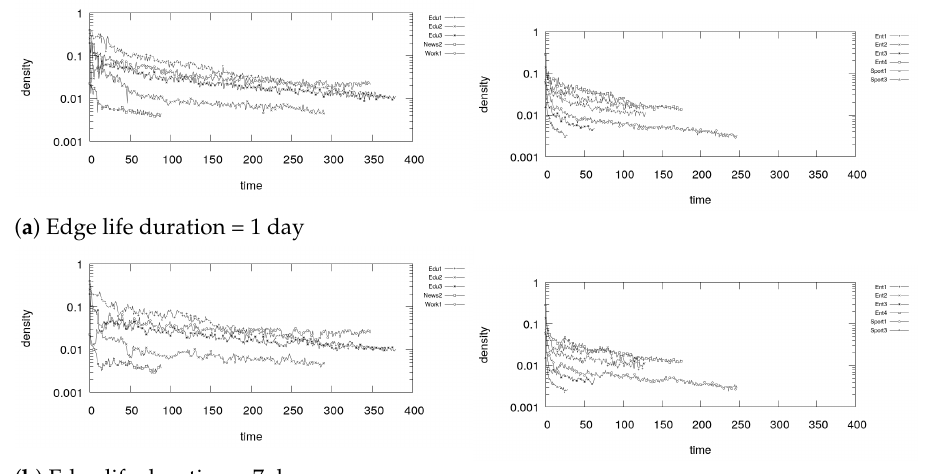
Figure 31. Internal density of communities detected by Fast Greedy.